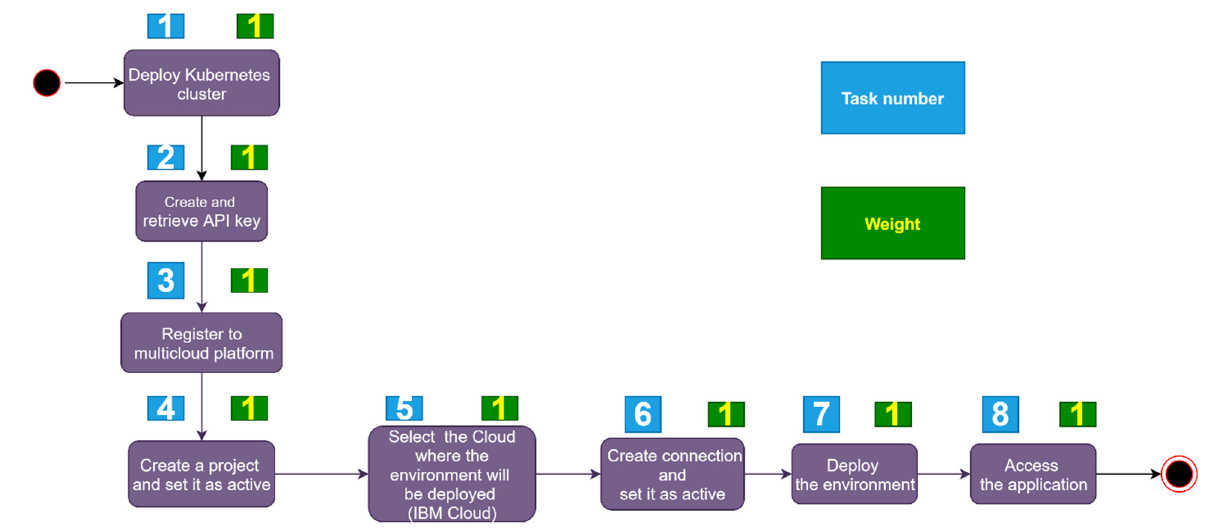
Figure 3. The weighted manual deployment process.